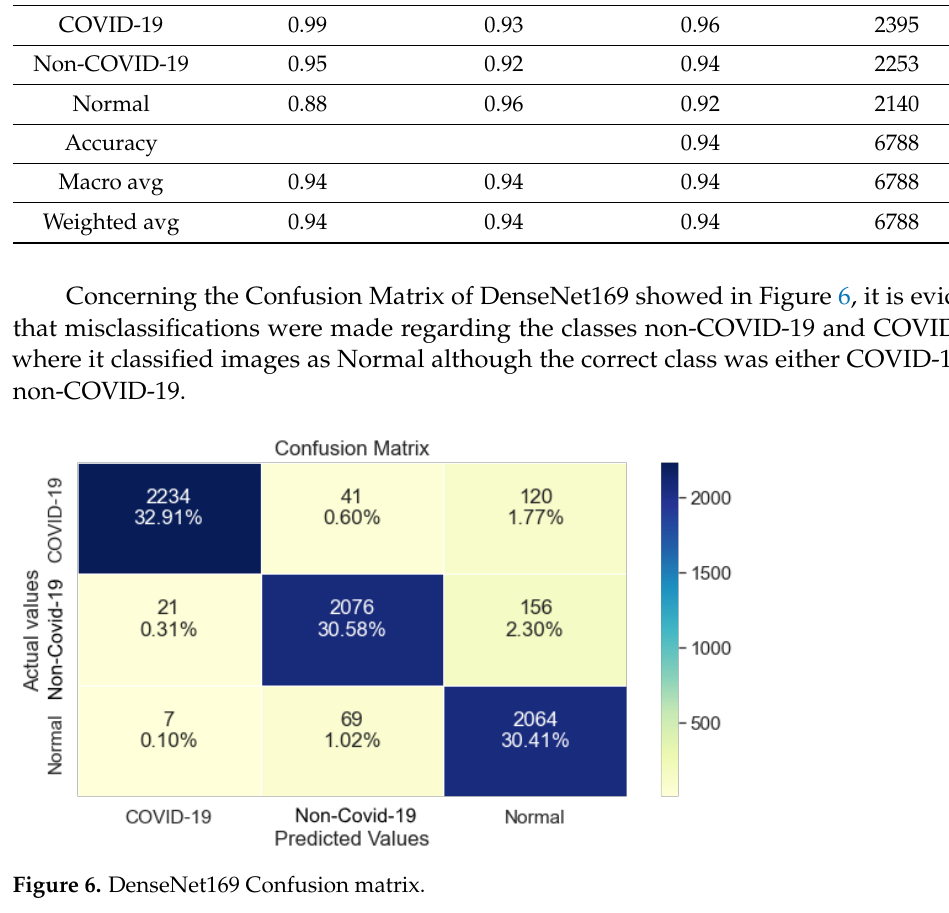
Table 6. DenseNet169 Evaluation results.